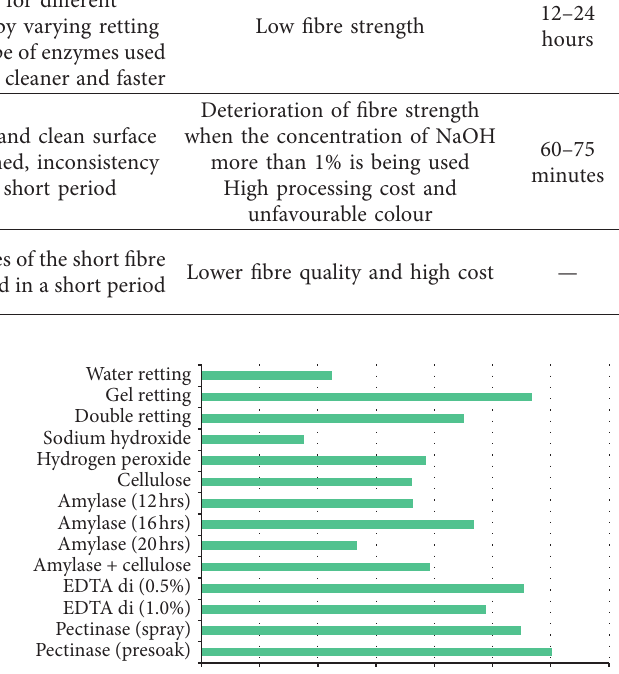
Figure 6: Shikha flax fibre yield from a variety of retting methods